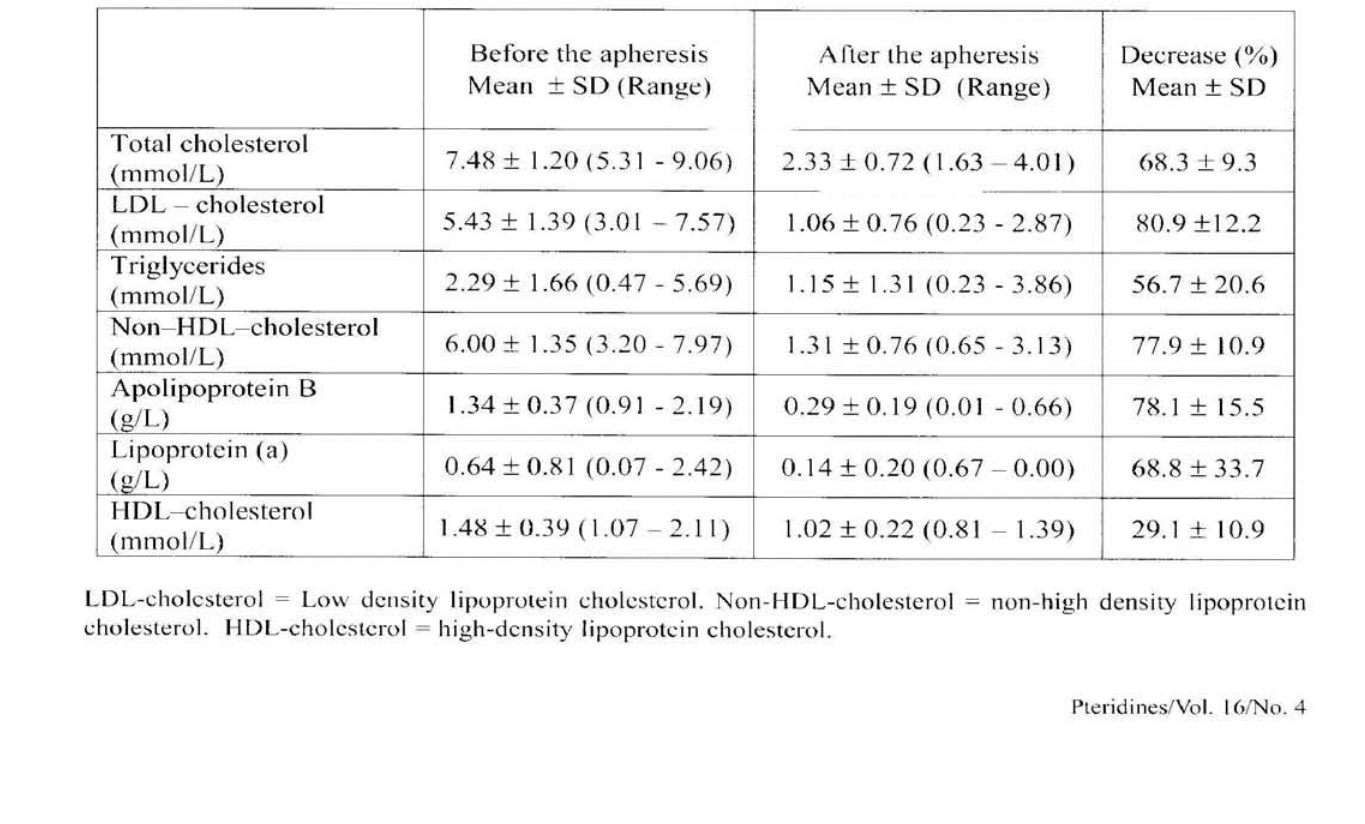
Table 2. Changes of serum